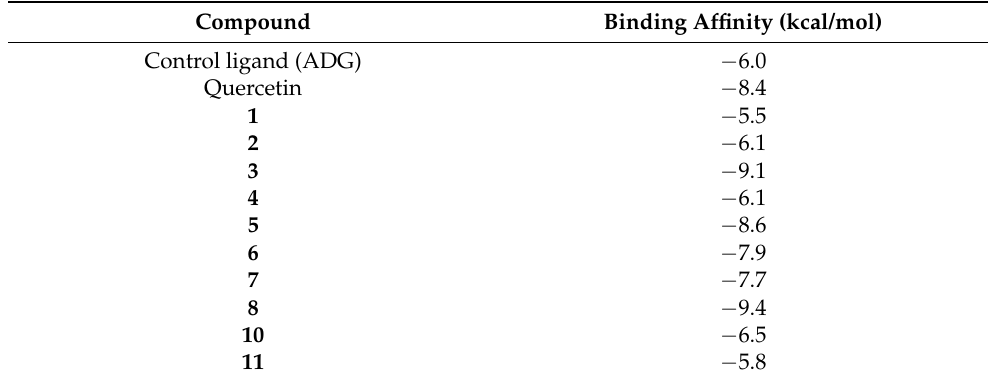
Table 7. Binding affinity values of α -glucosidase enzyme (3A4A) with ADG, quercetin and the identified ten active